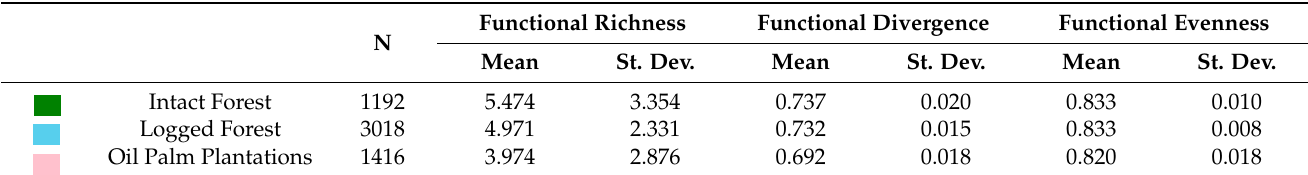
Figure 2. Differences in functional diversity metrics across land-use types are displayed in boxplots with the corresponding ANOVA results. The boxplots’ boxes represent the 25th, 50th, and 75th per- centiles and the whiskers depict the 10th and 90th percentiles. The annotated letters (a, b, c) indicate the significance of pairwise differences in retrieved trait estimates between land-use types according to post hoc Tukey’s HSD tests. Table 1. Descriptive statistics per functional diversity metric across land-use types in Sabah.